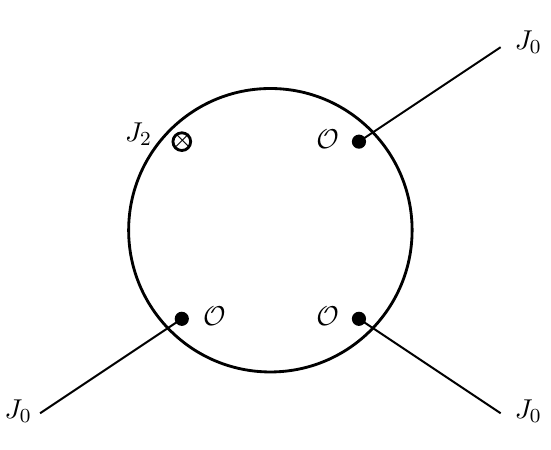
Figure 3 . Conformal four-point function h J 2 J 0 J 0 J 0 i in critical boson theory obtained from Leg- endre transformation of the four-point function h J 2 OOOi . The operator J 2 inside the circle is actually an external operator instead of from the